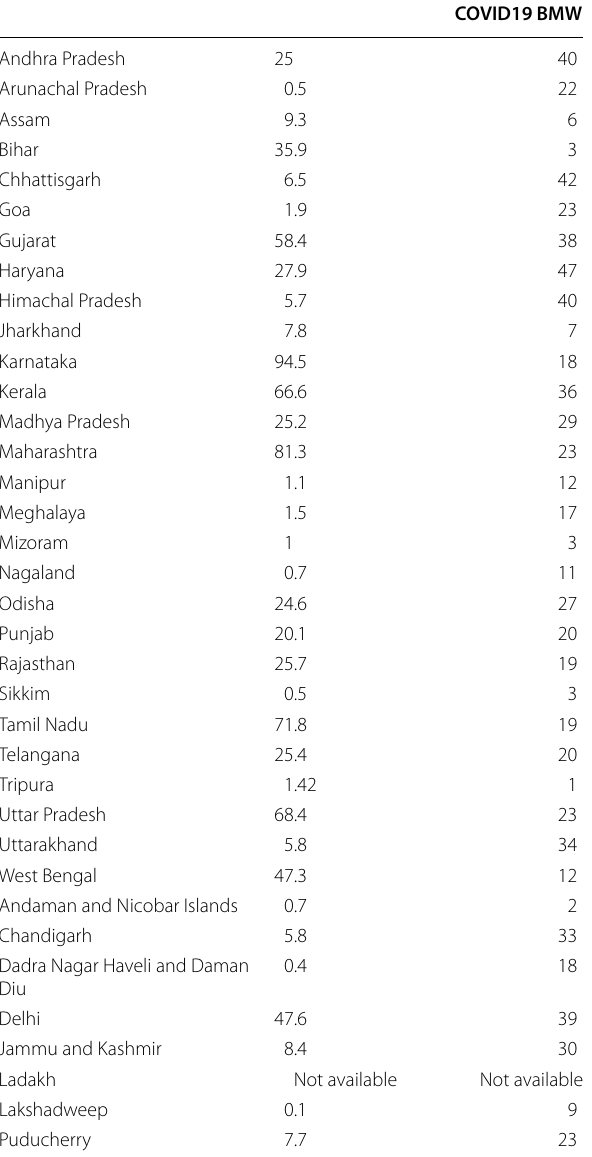
Table 3 Biomedical waste generated during pandemic second wave. Source : Central Pollution Control Board